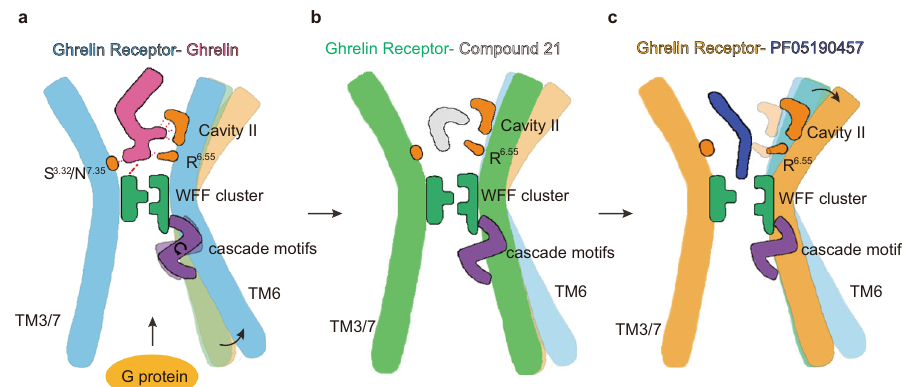
Fig. 6 Summary model of ghrelin receptor bound with inverse agonist, agonist, and antagonist. Simple model for PF-05190457 ( a ), ghrelin ( b ), and compound 21 ( c ) bound to the ghrelin receptor. Some of the essential residues and modules are marked with different colors and patterns. The cascade motifs referred to the combination of the P – I-F motif, E-R-Y motif, and NPxxY